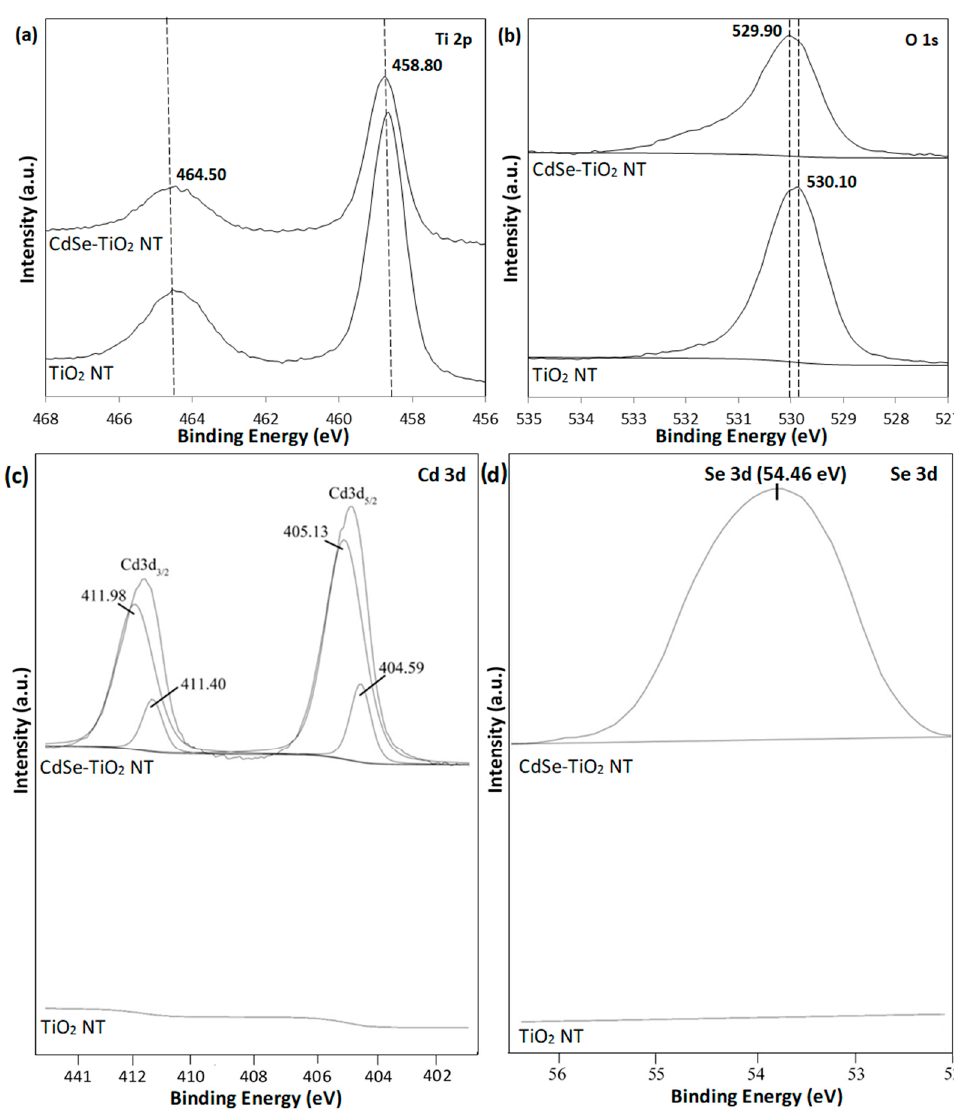
Figure 5. High-resolution XPS spectra of ( a ) Ti 2p, ( b ) O 1s, ( c ) Cd 3d, and ( d ) Se 3d of pure TiO 2 nanotube thin films and CdSe–TiO 2 nanotube thin films.